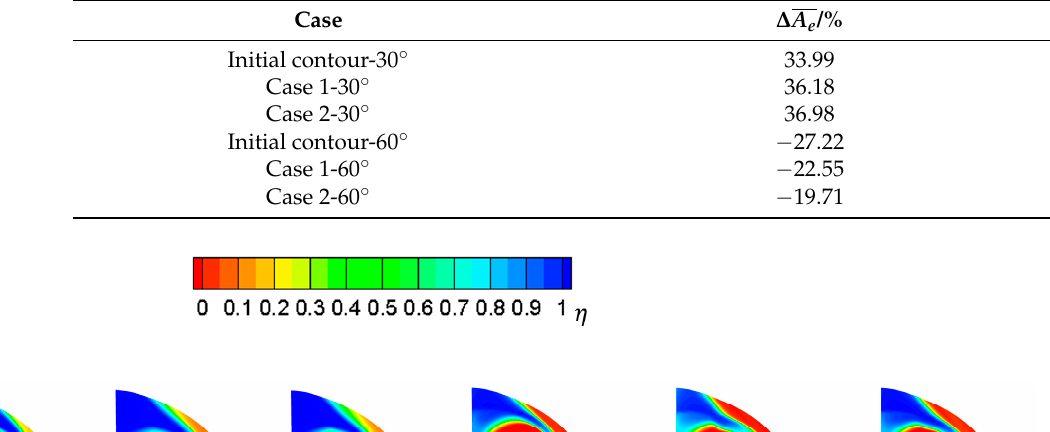
Figure 12. Schematic diagram of slotting angle. ( a ) Slotting angle = 30°. ( b ) Slotting angle = 45°. ( c ) Slotting angle = 60°. Table 6. The ∆ A e of different non-axisymmetric endwalls with variable Slotting angles.